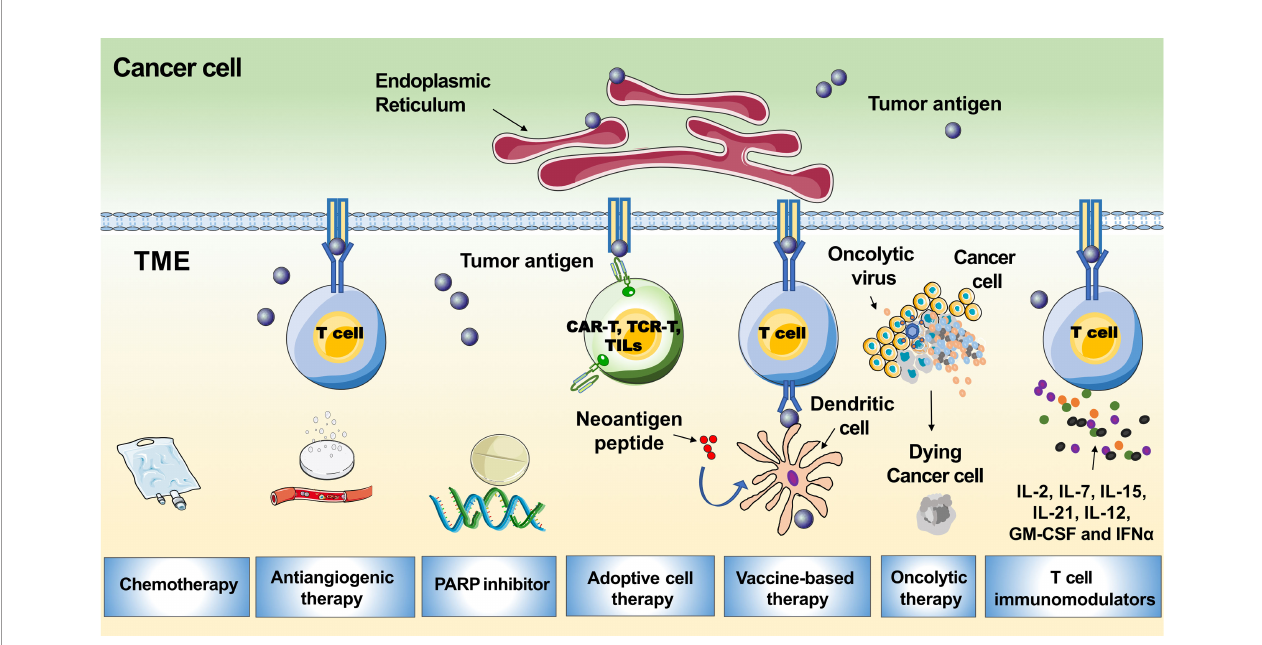
FIGURE 4 | Tumor microenvironment related immunotherapeutic strategies in ovarian cancer. The graph shows multiple therapies combined with PD-1/PD-L1 blockades to boost the immune response, including chemotherapy, antiangiogenic therapy, PARP inhibitor, adoptive cell therapy, vaccine-based therapy, oncolytic therapy and T cell